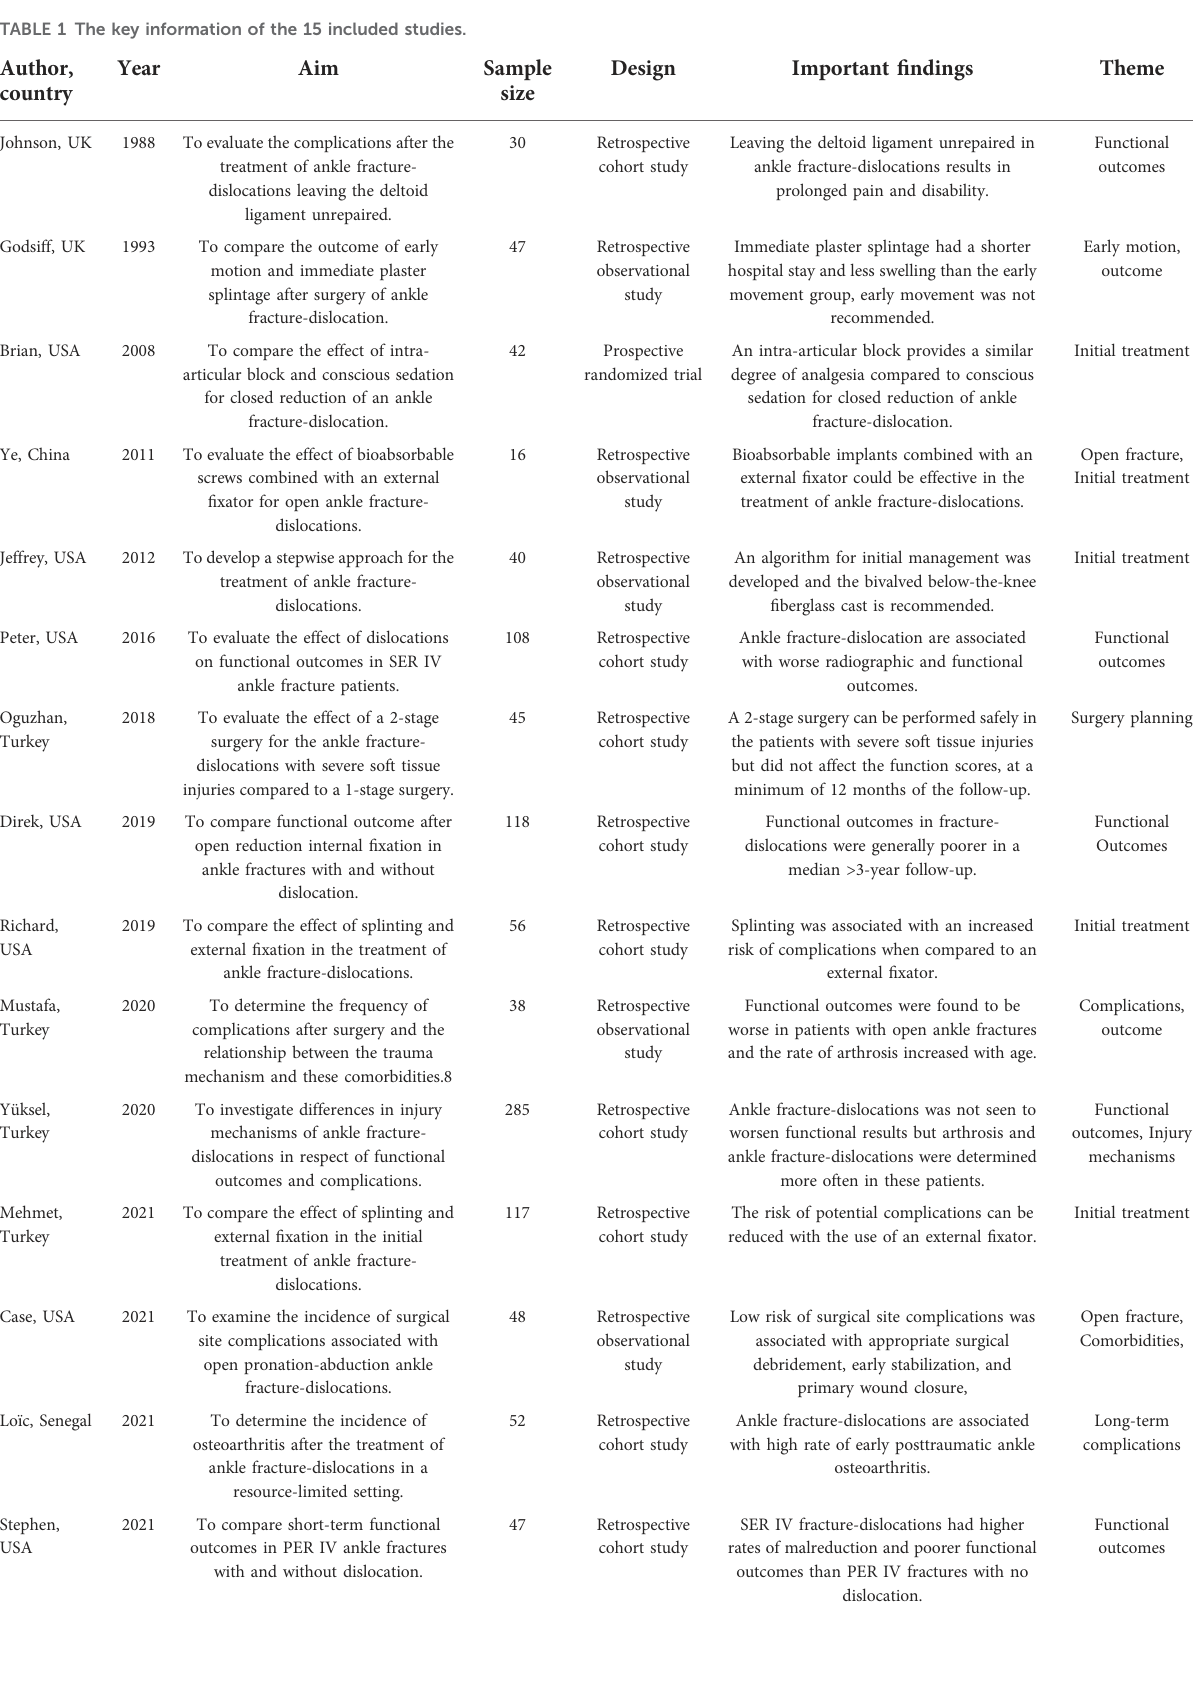
TABLE 1 The key information of the 15 included